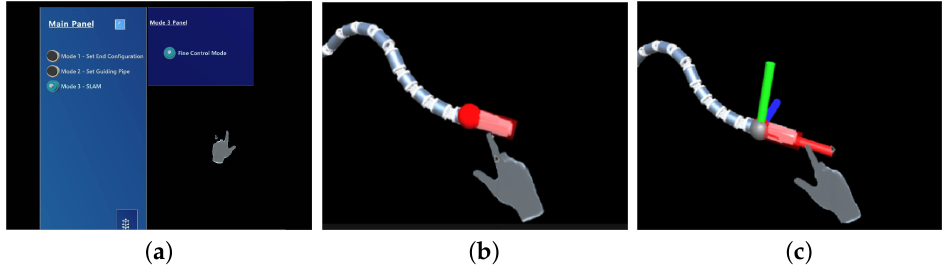
Figure 4. The MR-based interface. ( a ) Interaction panel. ( b ) Free target handle. ( c ) Anti-shake target